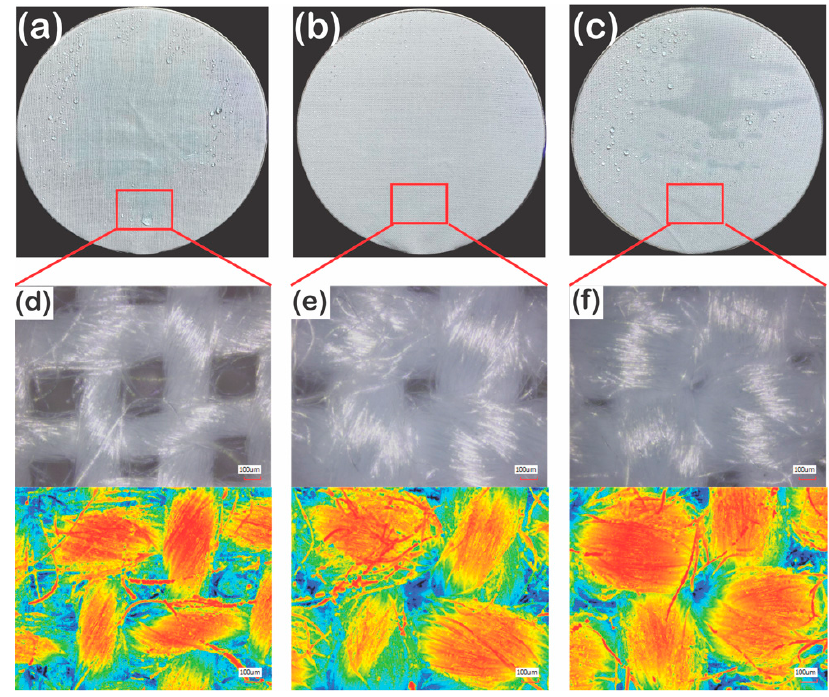
Figure 14. Photographs after water spraying test and optical images ( upper ) and laser images ( down ) of confocal microscope of 1% 4 min PDMS-coated PET fabrics: 177D ( a , d ), 314D ( b , e ), and 475D ( c , f